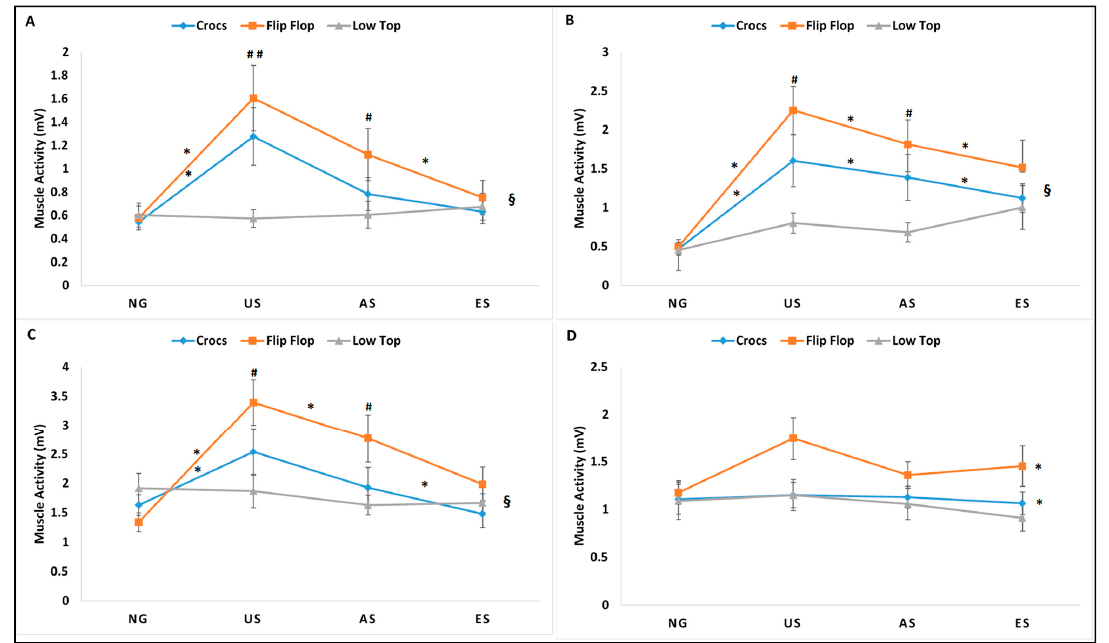
Figure 5. Peak muscle activity (mV) for vastus medialis ( A ), medial hamstrings ( B ), tibialis anterior ( C ), and medial gastrocnemius ( D ) during stance phase for Crocs, flip-flops, and low top slip resistant shoe during normal gait (NG), unexpected slip (US), alert slip (AS), and expected slip (ES) events. § denotes significant interaction between footwear type and gait/slip trial; * denotes significant difference for footwear across gait trials, and # denotes significant difference for gait trials across footwear. All differences were significant at the alpha level p < 0.05.